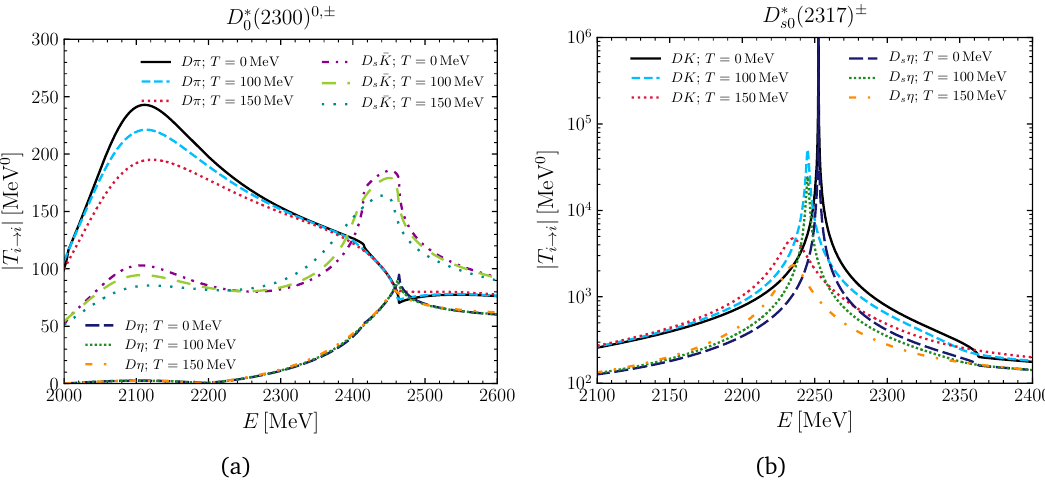
¯ K → D ¯ K scattering s s η → D η ones s s